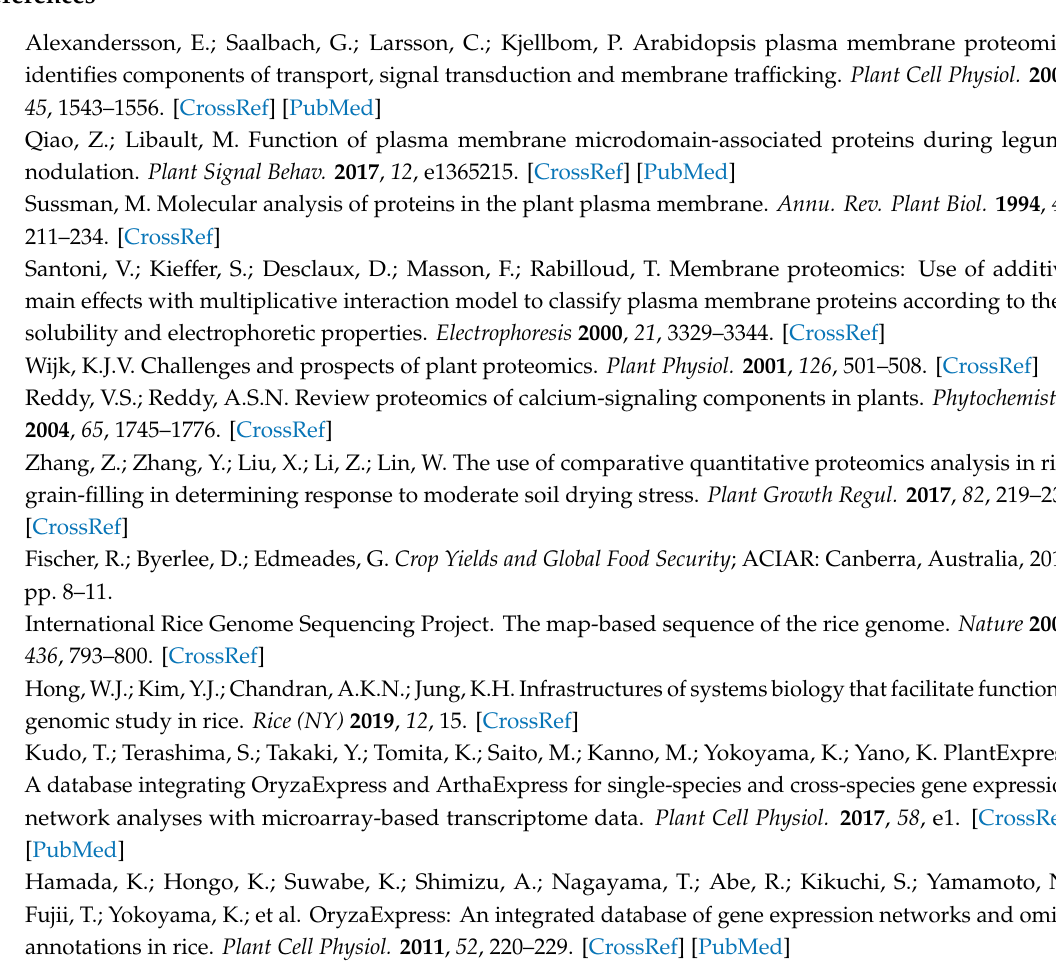
Table S1. Proteins identified in the plasma membrane fractions of rice root. Table S2. Proteins identified in the plasma membrane fractions of rice etiolated leaf. Table S3. Proteins identified in the plasma membrane fractions of rice green leaf. Table S4. Proteins identified in the plasma membrane fractions of rice leaf sheath. Table S5. Proteins identified in the plasma membrane fractions of rice flower. Table S6. Commonly accumulated proteins in the plasma membrane fractions of the five rice organs evaluated. Table S7. Organ-specific proteins in the plasma membrane fractions of the five rice organs evaluated. Table S8. Transport-related proteins in the root, etiolated leaf, and green leaf. Table S9. Cell-related proteins in the flower, leaf sheath, and green leaf. Table S10. Signaling-related proteins in the flower, leaf sheath, and green leaf. Table S11. Trypsin-digested fragments of rice heterotrimeric G protein